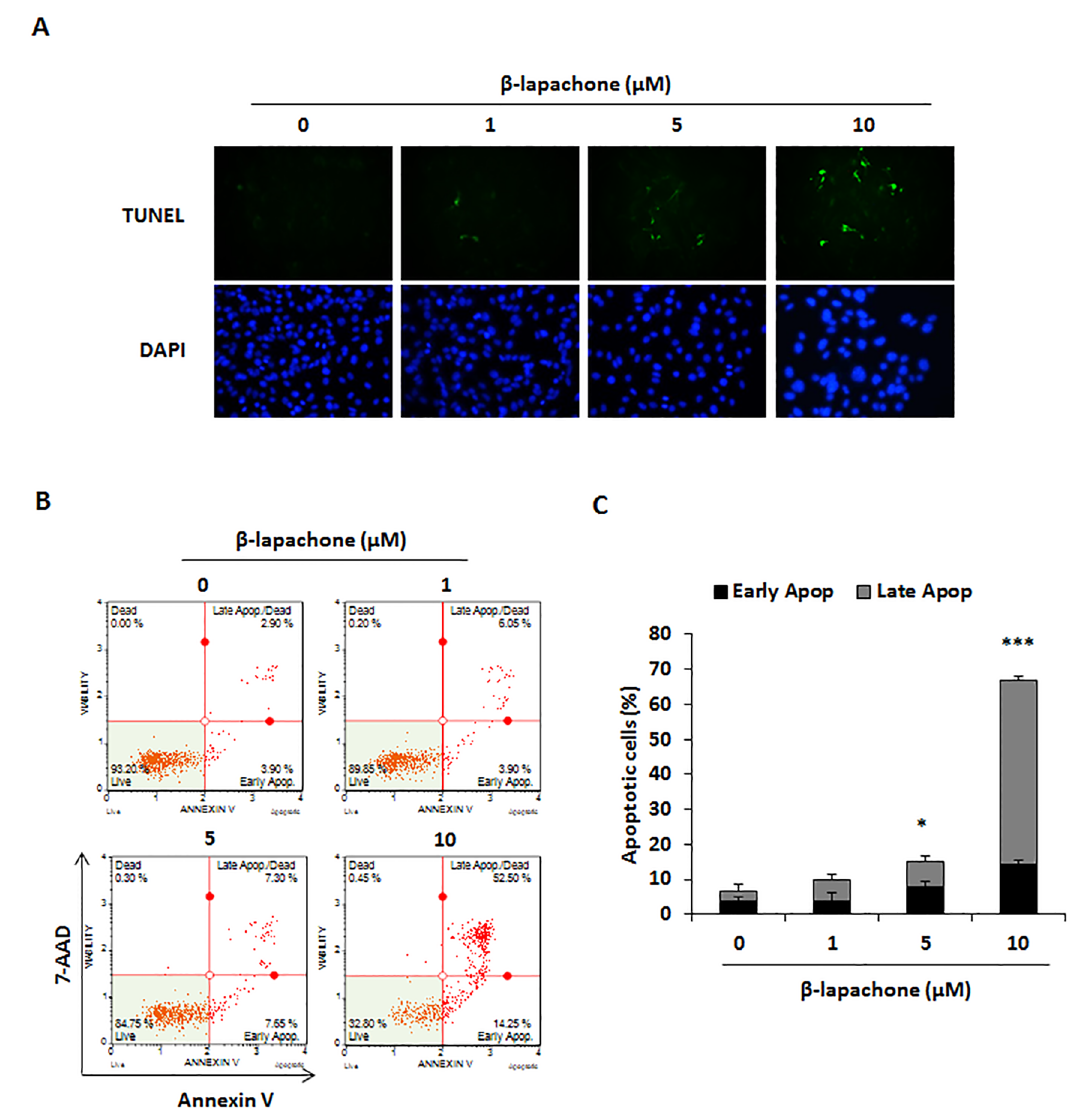
Fig 3. Effect of β -lapachone on the apoptosis of B16F10 cells. (A) β -Lapachone-inducedapoptosiswas observedby TUNEL assay under an inversionfluorescent microscope. B16F10 cells were incubatedwith indicatedconcentration of β - lapachone for 12 h. (B) B16F10 cells were incubatedwith the indicatedconcentrations of β -lapachonefor 12 h and analyzedby AnnexinV/7-AAD stainingand flow cytometry. The figure is representative of three independentexperiments. (C) The percentagesof apoptoticcells were plotted. Valuesare the means ± SD of data from three independent experiments. * P < 0.05 and *** P < 0.001.